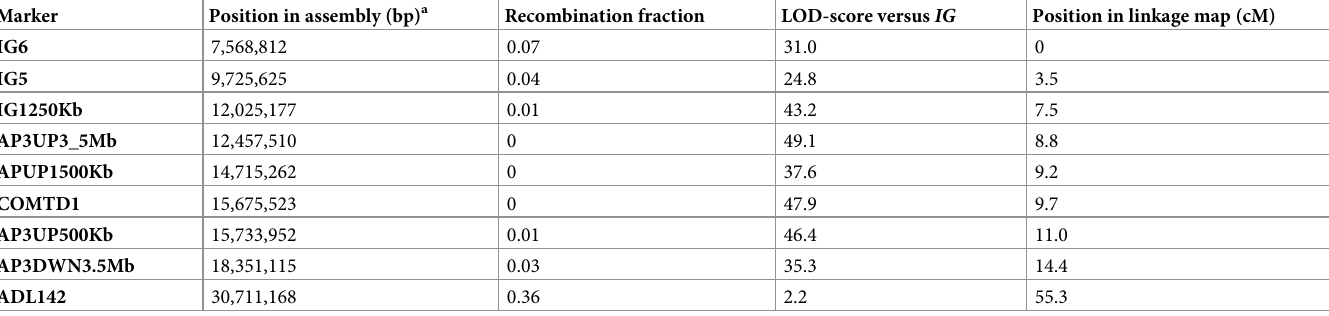
Table 1. Pair-wise linkage analysis between the IG locus and genetic markers on chicken chromosome 6.